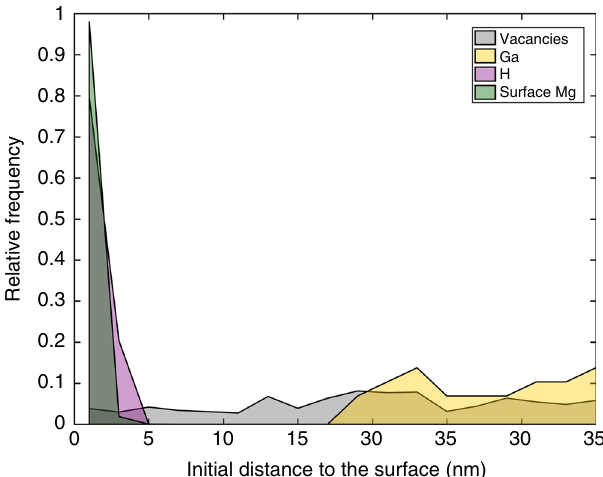
Fig. 6 Intermixing following implantation in pure Mg. Relative frequency of surface Mg, H, Ga and vacancies as a function of the distance to